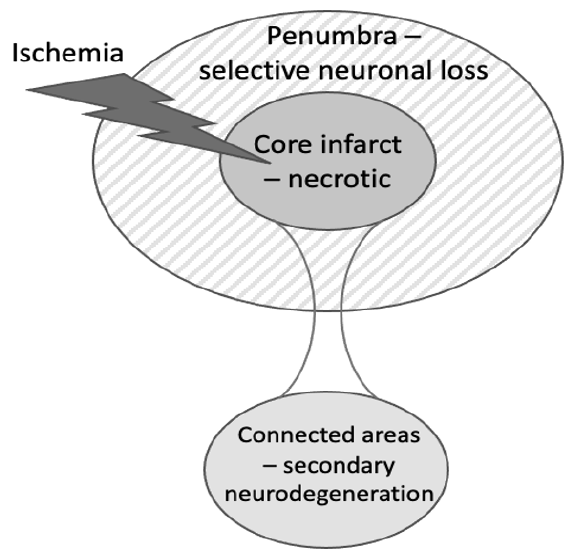
Figure 1. Types of cell death induced in different brain areas after stroke. In the brain area of deepest ischemia, virtually all cells die rapidly by necrosis, resulting in the infarct. In the ischemic penumbra surrounding the infarct, there is a delayed and selective loss of neurons. In brain areas distant from the infarct but neuronally connected to the infarct, there is a delayed loss of neurons, known as secondary neurodegeneration. Table 1. Published examples of delayed neuronal loss after stroke, indicating reference, stroke model used, site and time of neuronal loss.